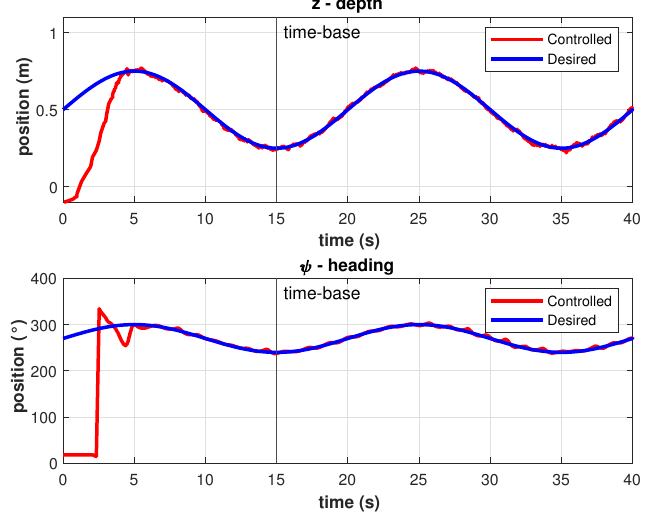
Figure 11. Controlled trajectory with the model-free high-order SMC with finite-time convergence in a 5 s predefined-time.